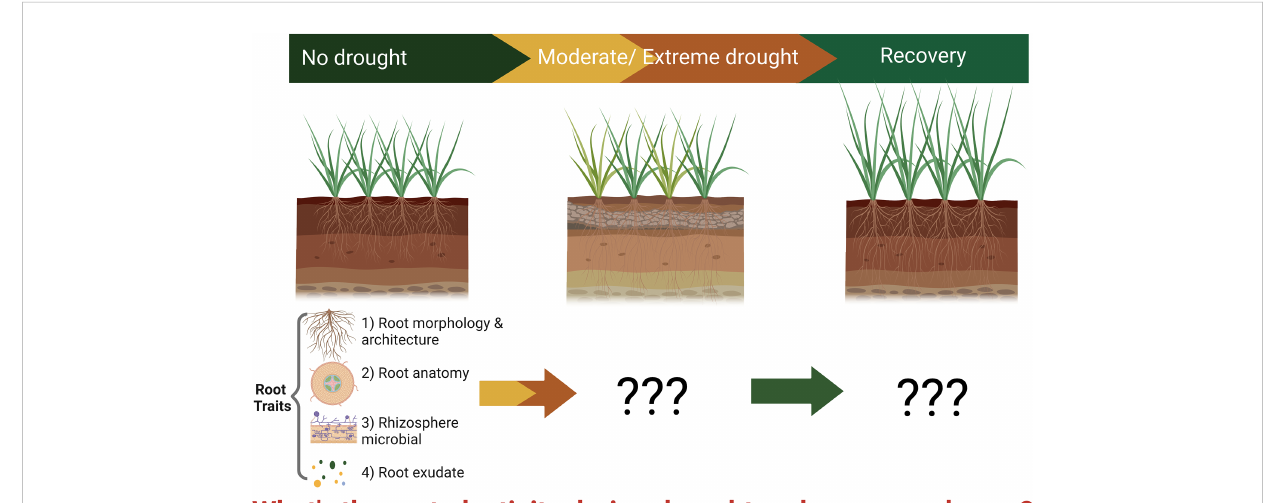
FIGURE 1 Schematic representation of root plasticity during drought and recovery. The image is created with BioRender. Created with